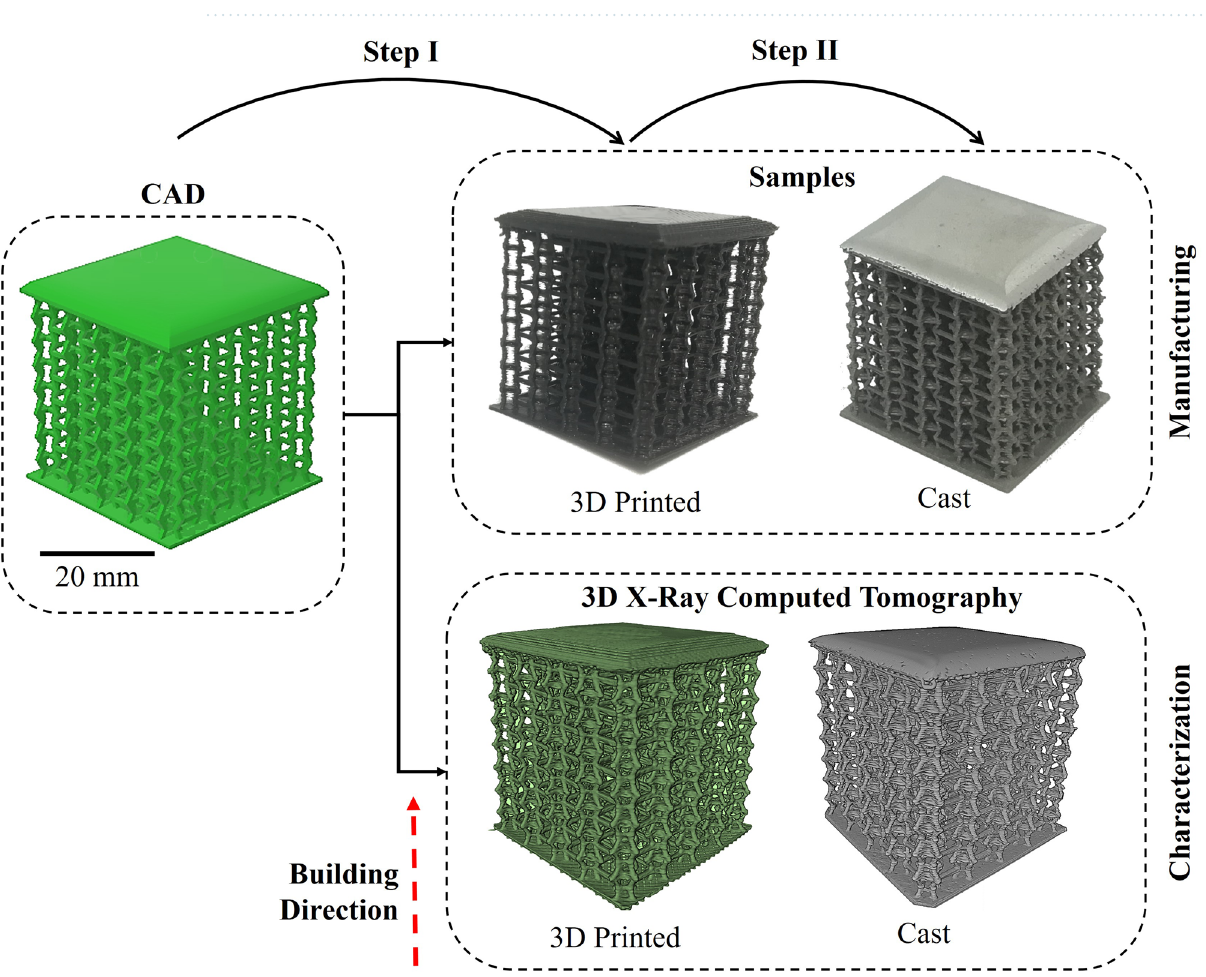
Figure 10. Steps for additive manufacturing and 3D characterization of assisted investment casting of metallic lattice structures from a CAD model to a 3D printed PLA pattern to the as-cast aluminium